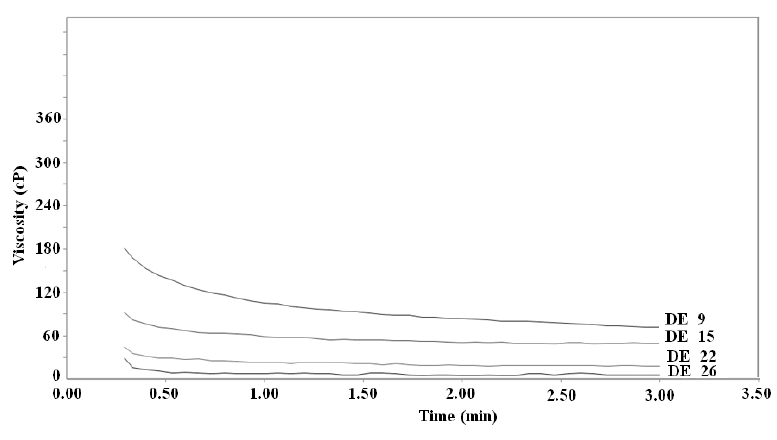
Figure 3. The dependence of viscosity on DE of various dextrins.